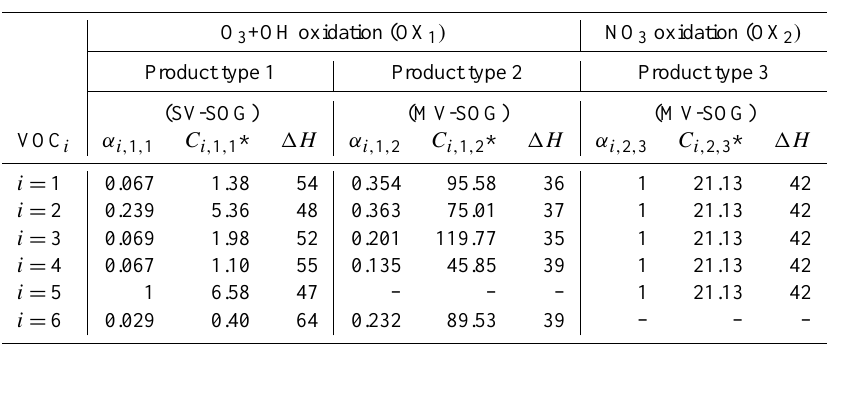
Table 1. Mass-based Stoichiometric yield ( α i,j,k ) for semi-volatile products ( k = 1–3) from the oxidation of major types of reactive biogenic volatile organic compounds (VOC i , i = 1–6) by different oxidants ( j = 1, 2), and the effective saturation concentrations ( C ∗ inµg/m 3 , inverse of equilibrium partition coefficient K i,j,k ) and the enthalpy of vaporization ( 1H , inkJmol − 1 ) of these products at T = 290K. i , j , k are the indices for VOCs, oxidants, and oxidation products, respectively. α i,j,k value along with equilibrium partition coefficient K i,j,k at reference temperature ( T ref ) for each SOG i,j,k can be found in Griffin et al. (1999a, b) and Kroll et al. (2006). 1H is based on the parameterization given in Eq. (7).